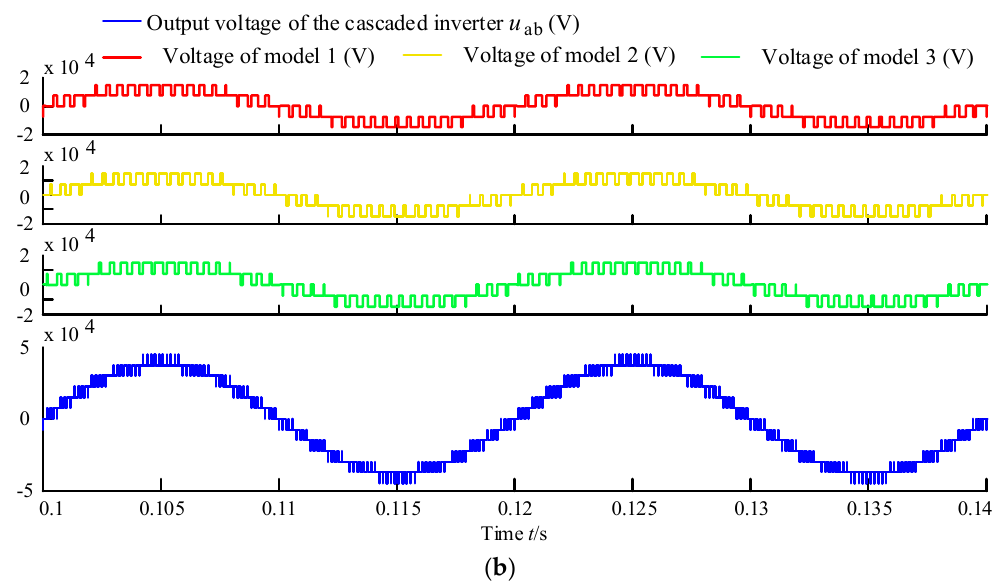
Figure 13. The output voltage and current waves of 3L-NPC cascaded inverter. ( a ) The output voltage and current wave of the three-model 3L-NPC cascaded inverter after filter; ( b ) the output voltage waves of the three single-phase 3L-NPC inverter and the output voltage of 3L-NPC cascaded inverter.